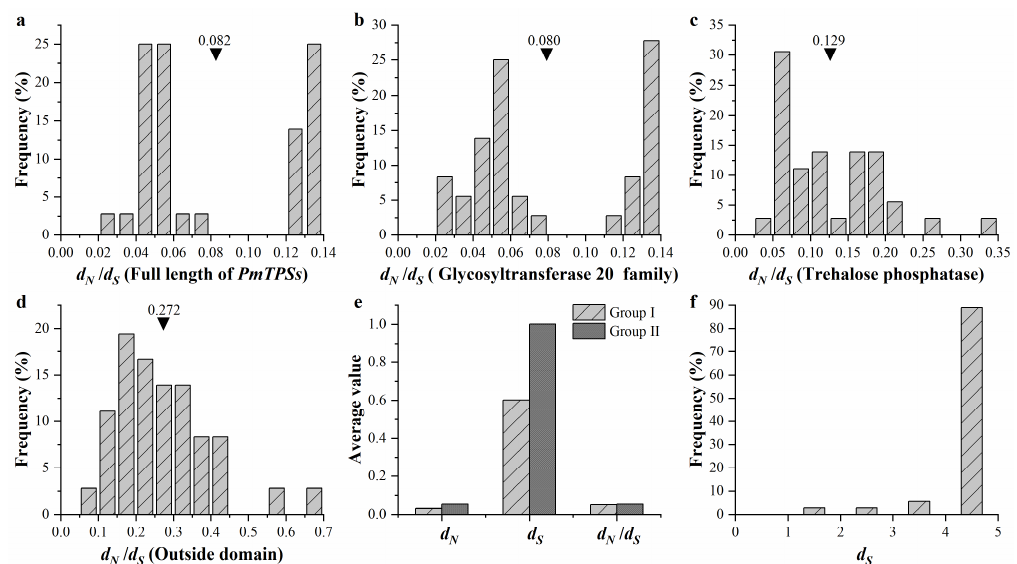
Figure 6. The selection pressure assessment with TPS gene pairs, genes domains, and two groups of the TPS family in Prunus mume . The frequency distributions of d N / d S for ( a ) the full length of PmTPS s, ( b ) glycosyltransferase 20 family, ( c ) trehalose phosphatase, and ( d ) outside domains, respectively. The black triangle represents the average value of d N / d S ratio. ( e ) The average value of d N , d S , and d N / d S in the Group I and Group II TPS family genes. ( f ) The frequency distribution of d S for TPS gene pairs in P. mume .